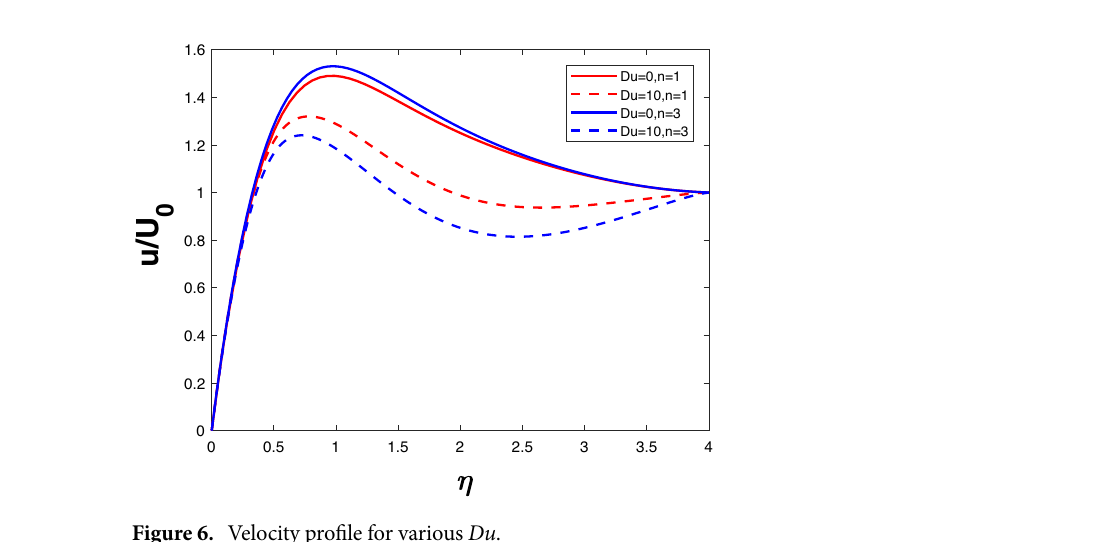
Figure 6. Velocity profile for various Du .